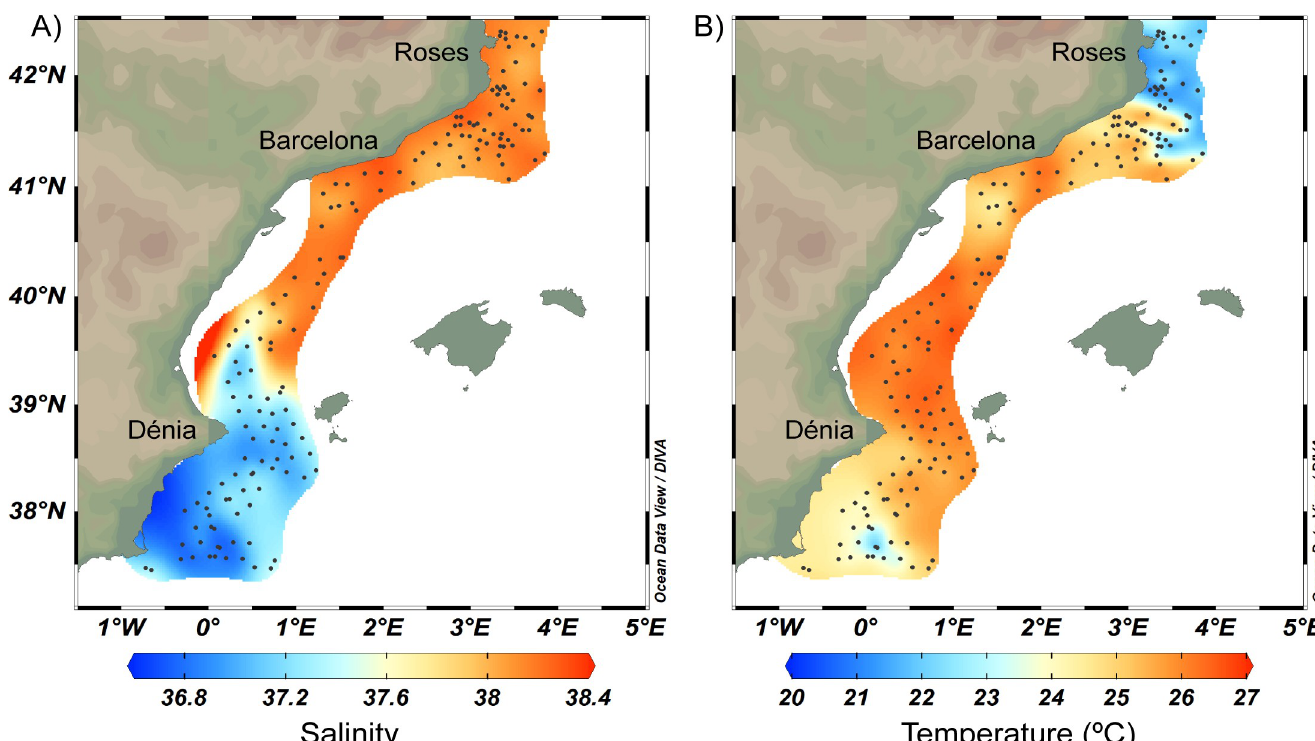
Fig 3. Horizontal distribution of a) salinity and b) temperature at 10 m depth from CTD data. Dots show the sampling stations. Images were created using ODV